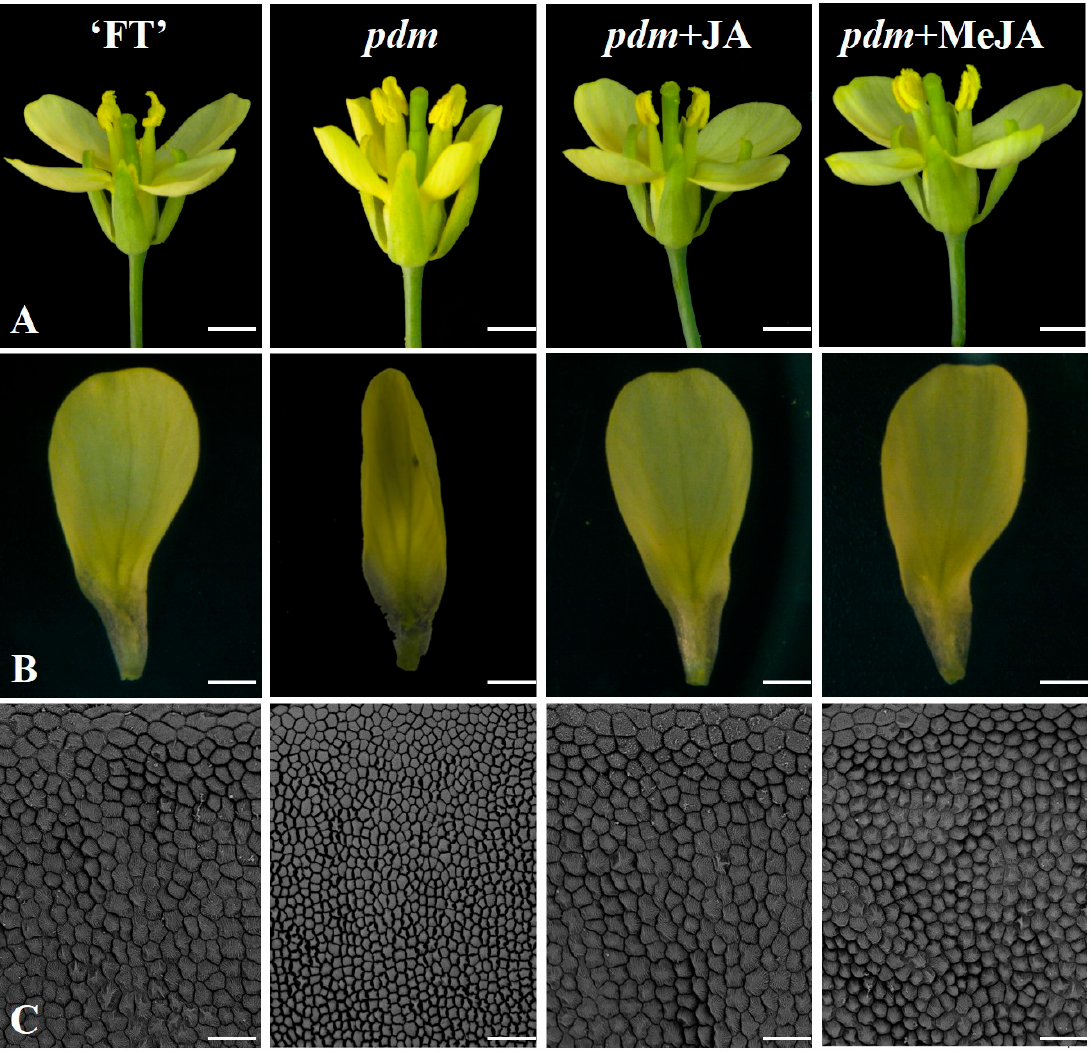
Figure 2. Phenotypic responses of ‘FT’ and pdm plants to exogenous treatments. ( A ) Flower, ( B ) petal, and ( C ) petal cells. (Scale bars: 20 μ m).